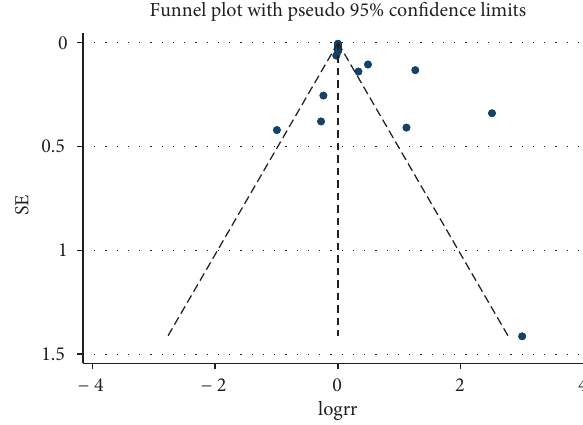
Figure 5: Funnel plot for mortality. Figure